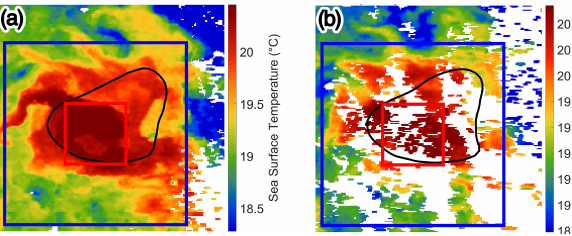
Figure 3. Examples with different Cloud Coverage. Snapshots represent Sea Surface Temperature in degrees. Contours and squares are the same as Figure 2. Snapshots of the same eddy (Ierapetra) on different days of December 2016 ( a ) 19/12, ( b ) 20/12, ( c ) 29/12, and ( d ) 30/12. Cloud coverage percentage is increasingly high. Examples ( a , b ) are retained, while ( c , d ) are not